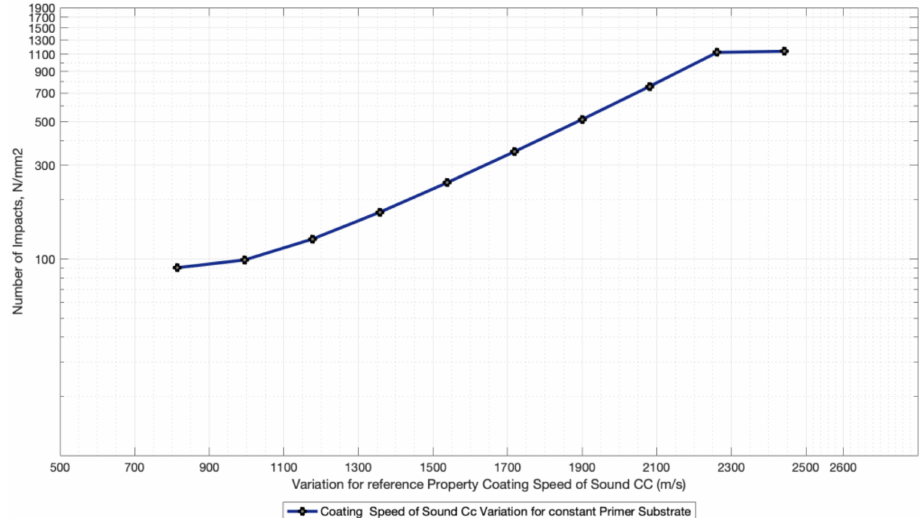
Figure 24. Incubation time (Number of impacts until failure) numerical estimation, due to a unique variation of the coating wave speed Cc when considering the Primer as the substrate layer.